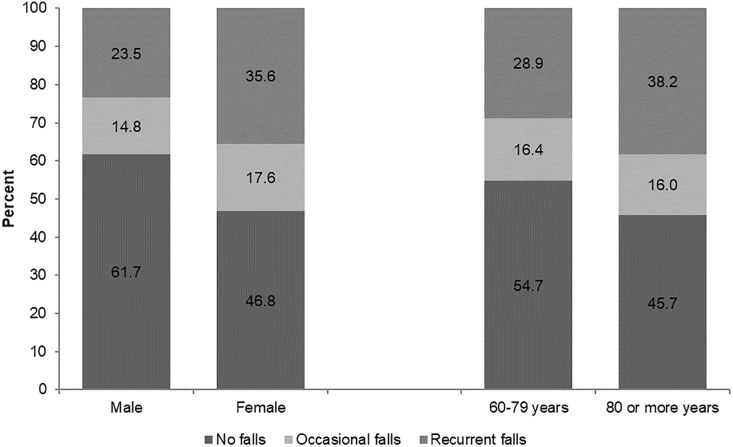
Self-reported incidence of falls over the last two years in older Mexican adults by sex and age group.Mexico, 2015.